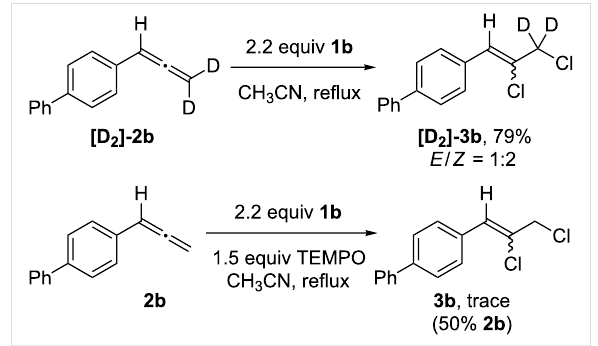
nation of allenes with 1a proceeded without interruption of 1,2- phenyl shifts or iodane elimination, resulting in a reactivity pattern that differs from the related reagents TolIF 2 , PhI(OH)OTs or PhI(NTs 2 ) 2 (Scheme 1b and c). With 1b ,